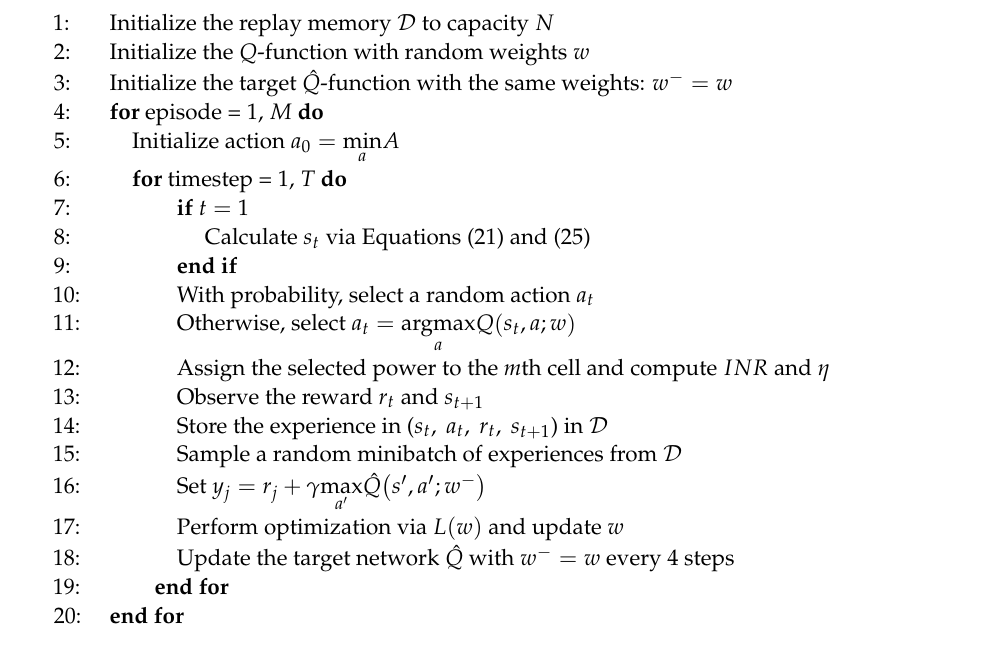
Algorithm 1. Training Process for the DQL-Based HAPS Power Control